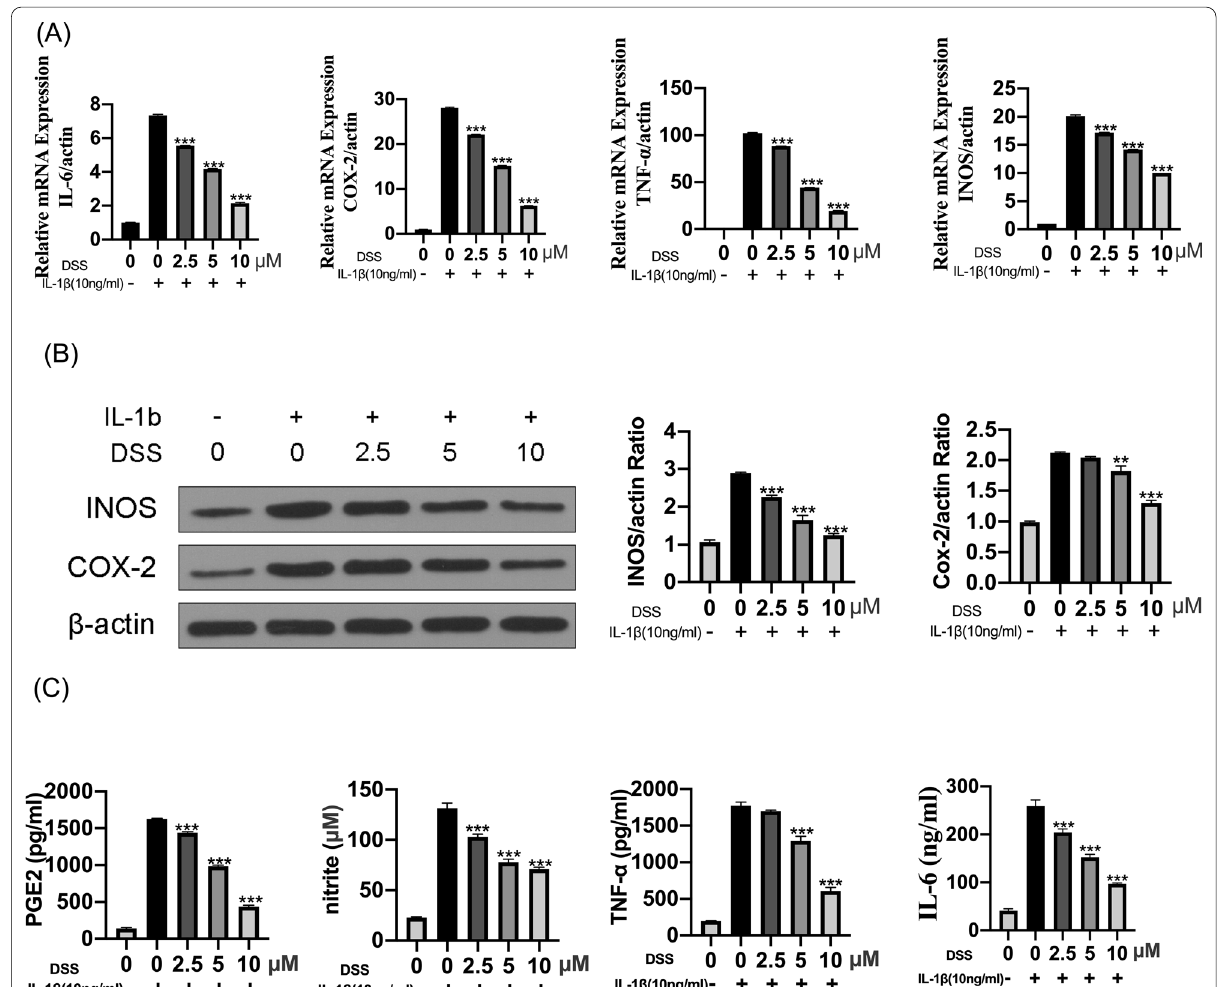
Fig. 2 DSS inhibited IL-1β-induced chondrocytes inflammation. The chondrocytes were pretreated with 2.5, 5, and 10 μM DSS for 24 h and stimulated with 10 ng/ml IL-1β for 2 h. A The mRNA levels of inflammation-related markers IL-6, COX-2, TNF-α, and iNOS were evaluated by qRT-PCR. B The protein levels of iNOS and COX-2 was detected by Western blot with β-actin as the internal reference. C The production of PGE2, TNF-α, NO, and IL-6 were detected by ELISA. **p < 0.01; ***p < 0.001